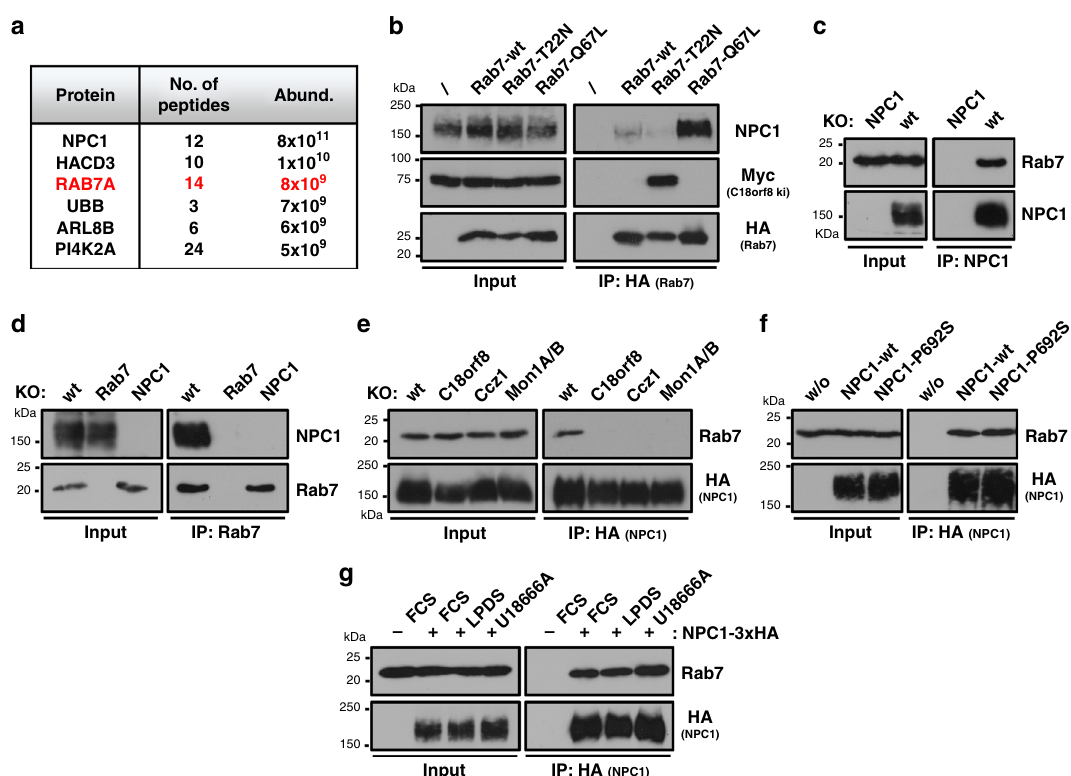
Fig. 8 Rab7 interacts with the lysosomal cholesterol transporter NPC1 in an activation-dependent manner. a Immune-precipitation of HA-tagged NPC1 and detection of NPC1-interacting proteins using mass spectrometry. Most abundant interaction partners detected with >2 peptides are indicated (full dataset available in Supplementary Data 2 and via ProteomeXchange with identi fi er PXD021444). b Immune precipitations of HA-tagged wild-type, dominant-negative (T22N) or constitutively active Rab7 (Q67L) show an activation-dependent interaction between Rab7 and endogenous NPC1 (two independent experimental replicates). c , d Reciprocal immune-precipitation of endogenous NPC1 ( c ) or Rab7 ( d ) shows a strong interaction between both proteins. e The Rab7-NPC1 interaction is lost in MCC -de fi cient cells that lack Rab7 activation. Wild-type, C18orf8 -, Ccz1 - and Mon1A/B -de fi cient cells were stably transduced with the inactive NPC1-P692S-HA. HA-tagged NPC1 was immune precipitated and immune blotted for endogenous Rab7. The inactive NPC1-P692S was used to prevent altering lysosomal cholesterol content by NPC1 overexpression. (two independent experimental replicates) f , g The Rab7-NPC1 interaction is independent of NPC1 activity or lysosomal cholesterol levels. f NPC1 -de fi cient cells were complemented with HA-tagged wild-type or inactive P692S-mutant NPC1 and NPC1-HA immune-precipitations were analysed by immune blotting for endogenous Rab7. g Wild-type NPC1-HA complemented cells were treated with LPDS to decrease, or U18666A to increase lysosomal cholesterol levels and the NPC1-Rab7 interaction was probed using immune precipitation (two independent experimental